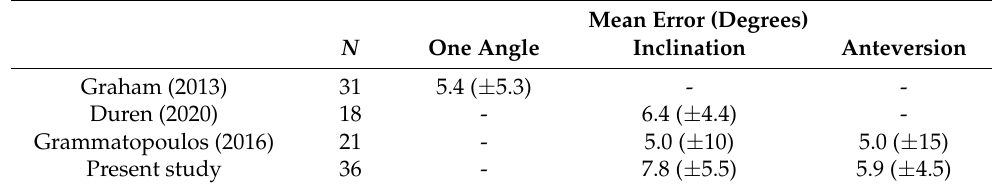
Table 6. Mean error in in vitro studies with